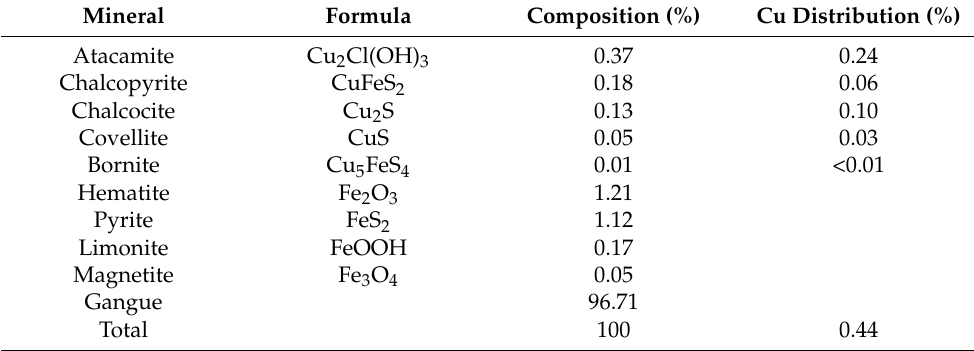
Table 2. Mineral characterization in the ore